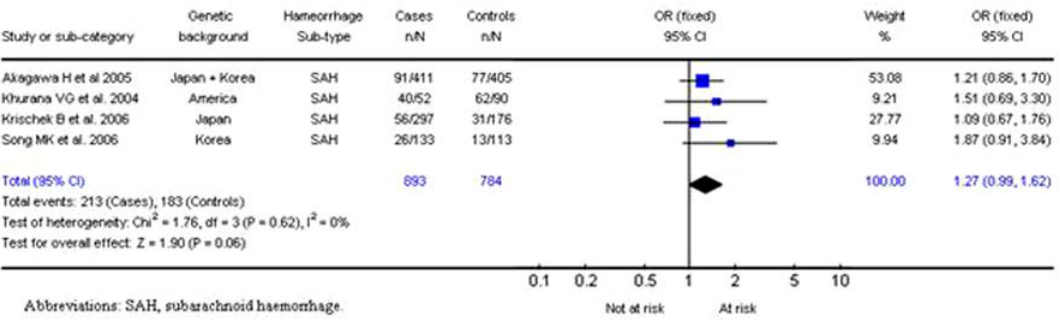
Figure 7. Results for eNOS/786C polymorphism and subarachnoid haemorrhage.